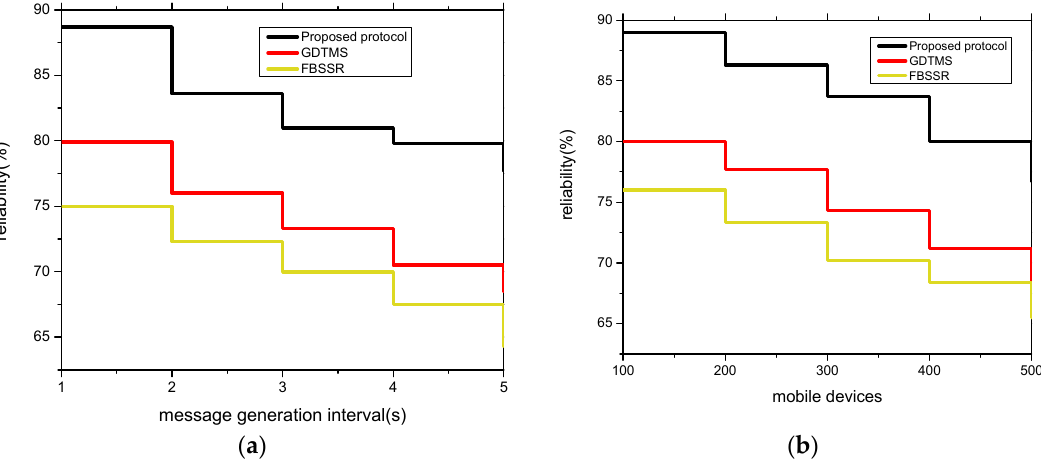
Figure 7. ( a ) Reliability with message generation interval. ( b ) Reliability with mobile devices.